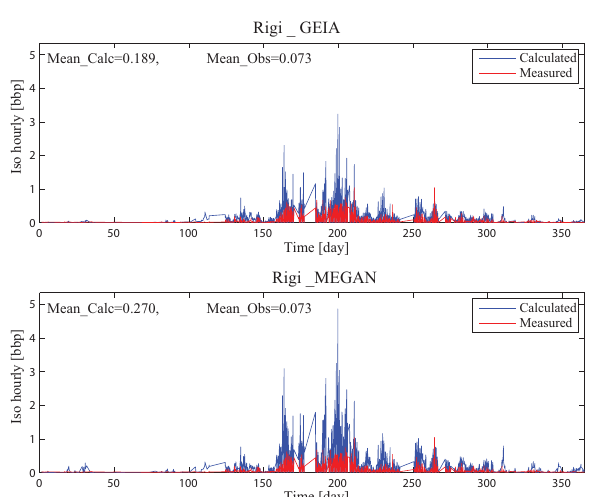
Fig. 10. Validation of the DEHM model results of isoprene con- centrations using the MEGAN and GEIA biogenic models in 2006 against measurements for the background station Rigi in Switzer-